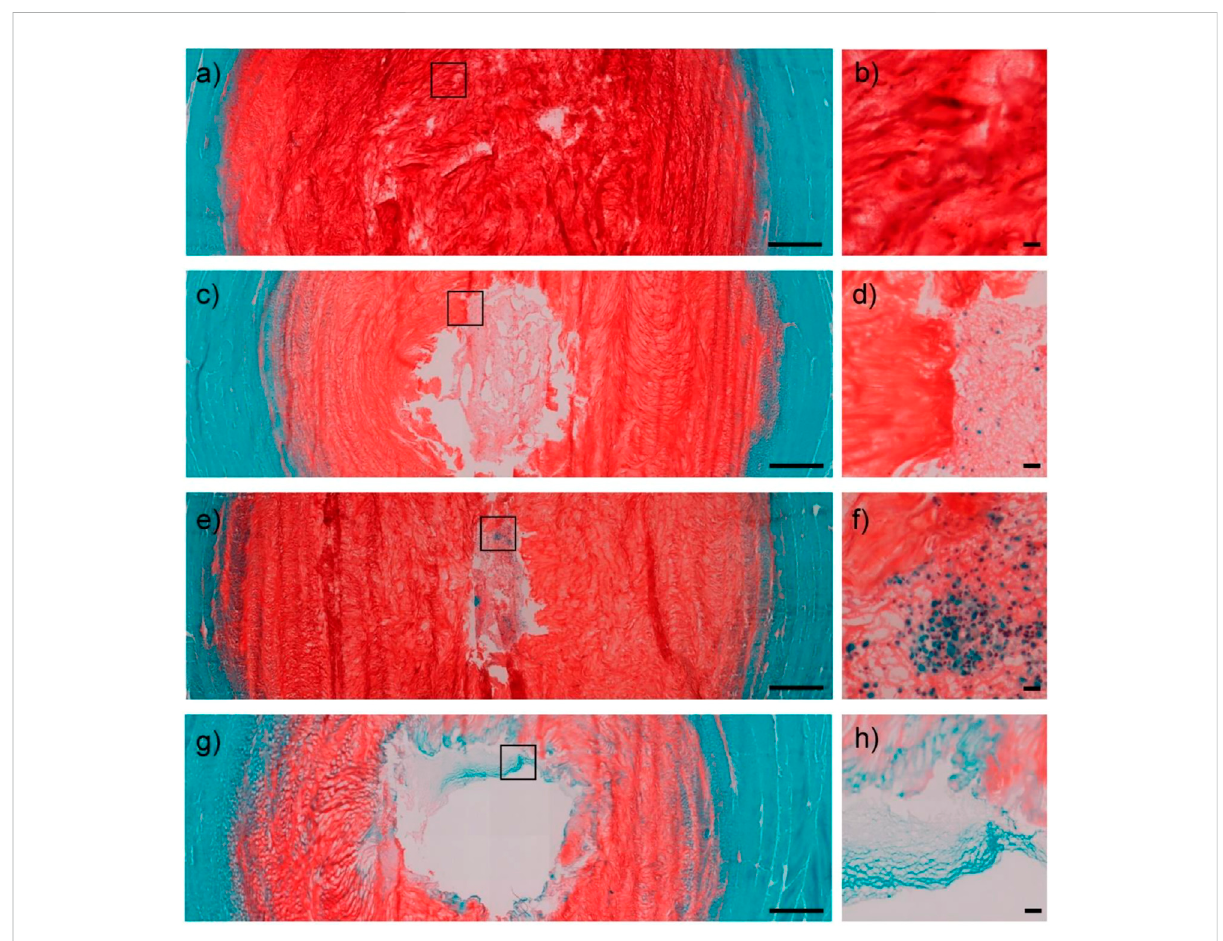
FIGURE 4 IVDcross-sections werevisualized using safranin O/fastgreen staining. Healthy disc controls inlow (1.25×) (A) and high (20×) (B) magni fi cation images. Low cell density hydrogel (1 million MSCs) in low (1.25×) (C) and high (20×) (D) magni fi cation images. High cell density hydrogel (2 million MSCs) in low (1.25×) (E) and high (20×) (F) magni fi cation images. Only hydrogel group in low (1.25×) (G) and high (20×) (H) magni fi cation images. Scale bar = 1,000 μ m (low magni fi cation); 50 μ m (high magni fi cation). Reproduced with permission from (Russo et al.,